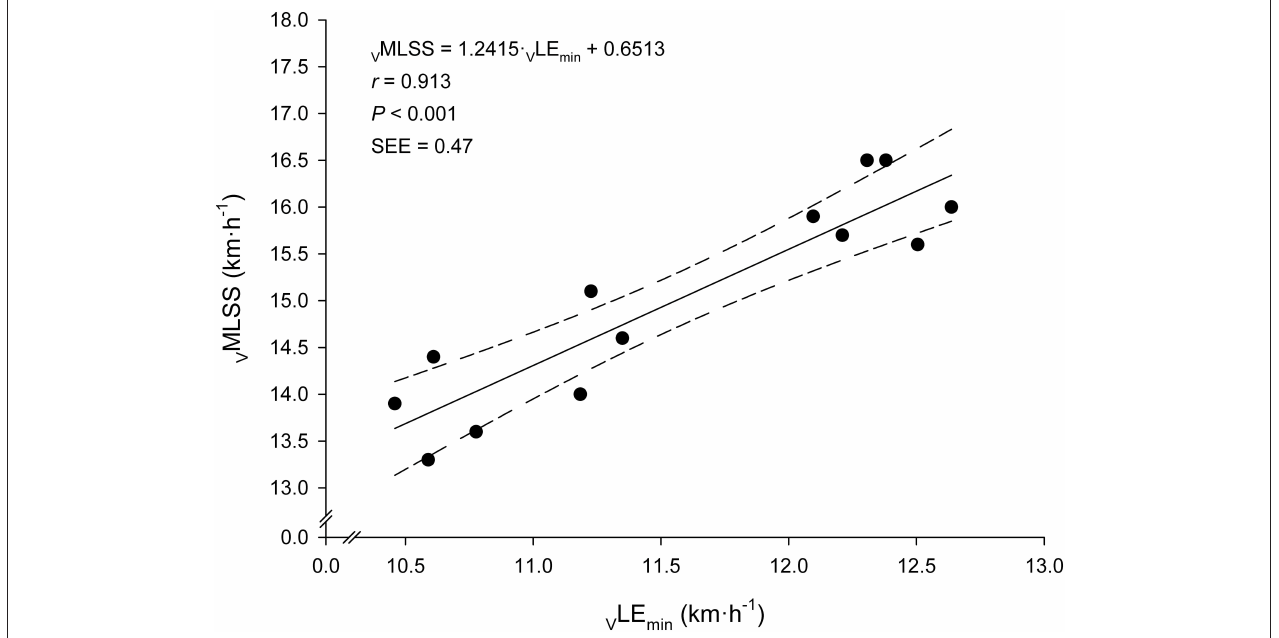
FIGURE 4 | Linear relationship between the velocity at the Minimum Lactate Equivalent ( V LE min ) and the velocity at the Maximal Lactate Steady State ( V MLSS). Solid line: linear regression. Dashed lines: 95% confidence intervals.